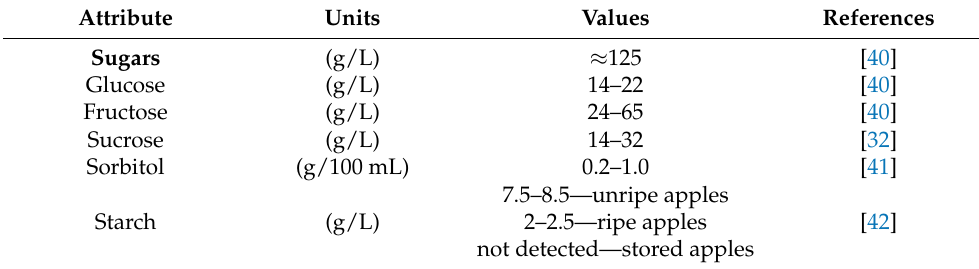
Table 2. The average composition of cider apple